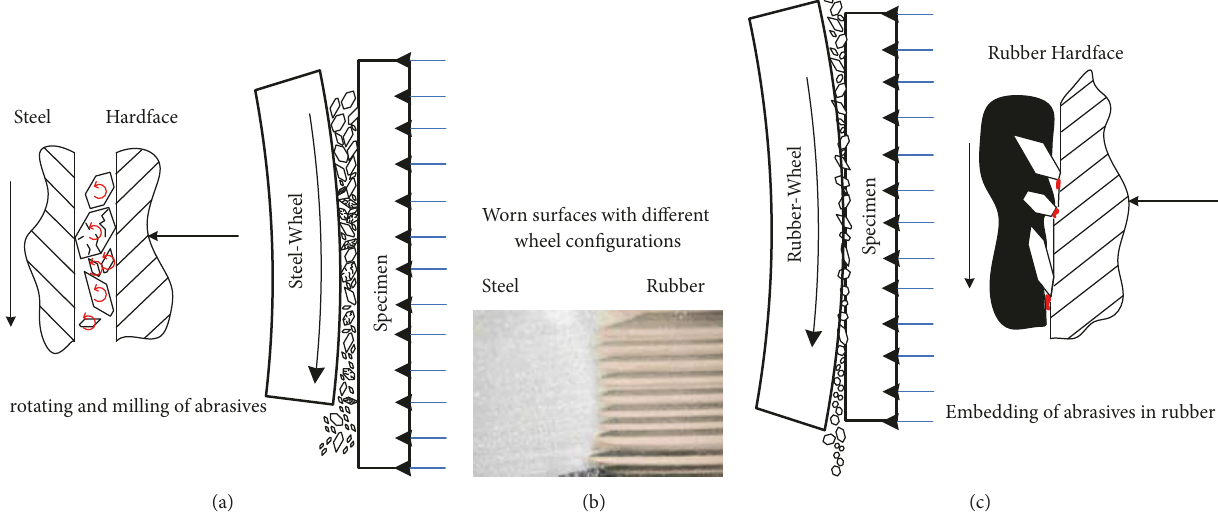
Figure 5: Explanation of the differences of the two types FWT configuration and friction surfaces generated with steel and rubber wheel as